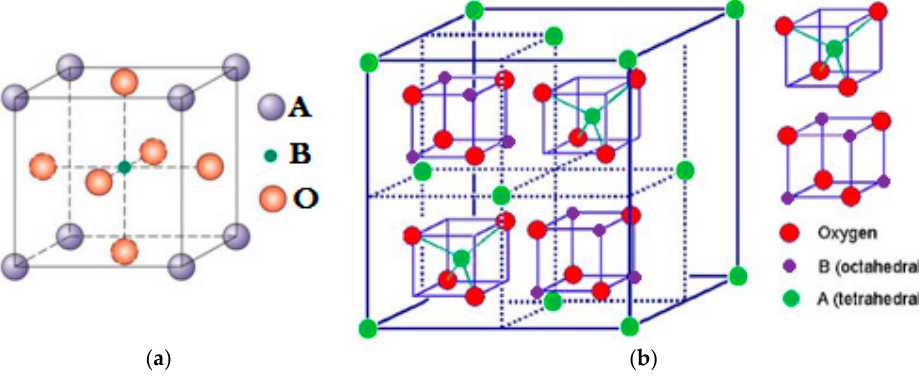
Figure 3. Structure of ( a ) perovskite crystal and ( b ) spinel structure.